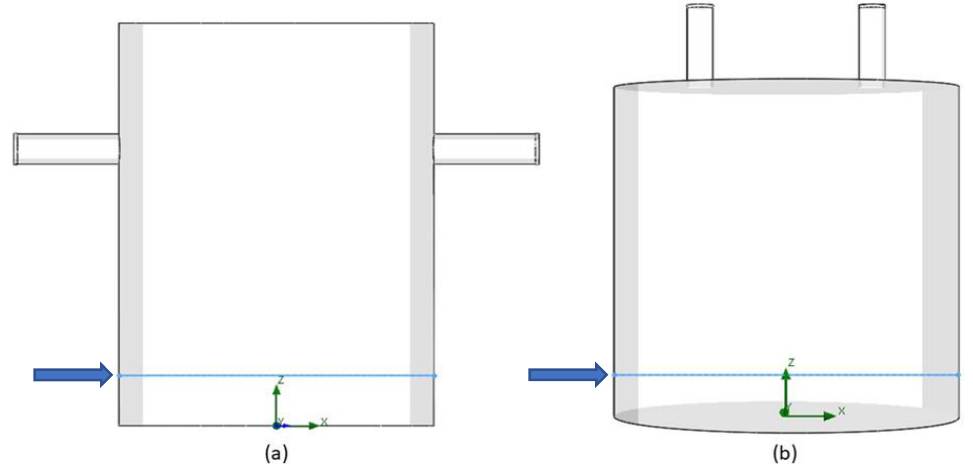
Figure 4. ( a ) Model of geometry with lateral inlet and outlet with line drawn at 7 cm from the upper region of reaction cell; ( b ) Model of geometry with upper inlet and outlet with line drawn at 7 cm from the upper region of reaction cell.